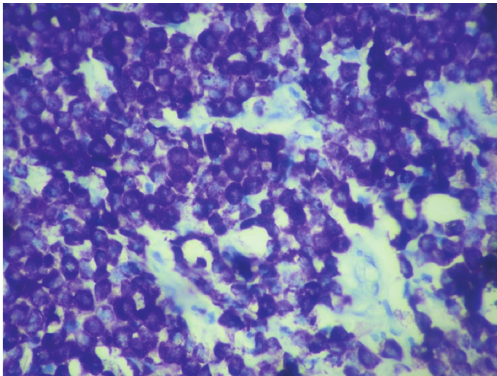
Figure 1: H&E stain. Skin with infiltrate of mast cells in the deep dermis.